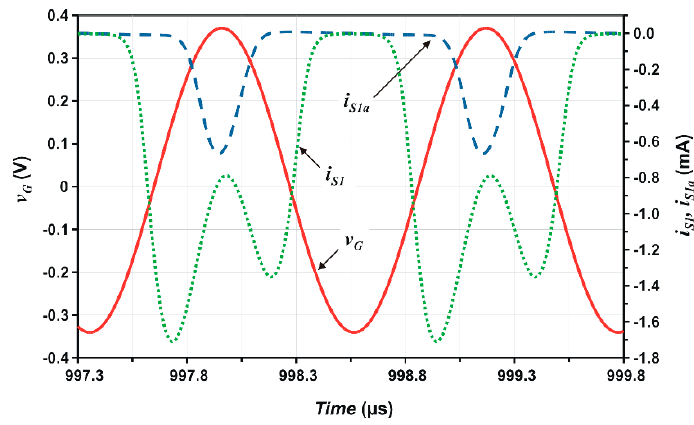
Figure 6. Time waveforms of the signals in the improved HSCO.